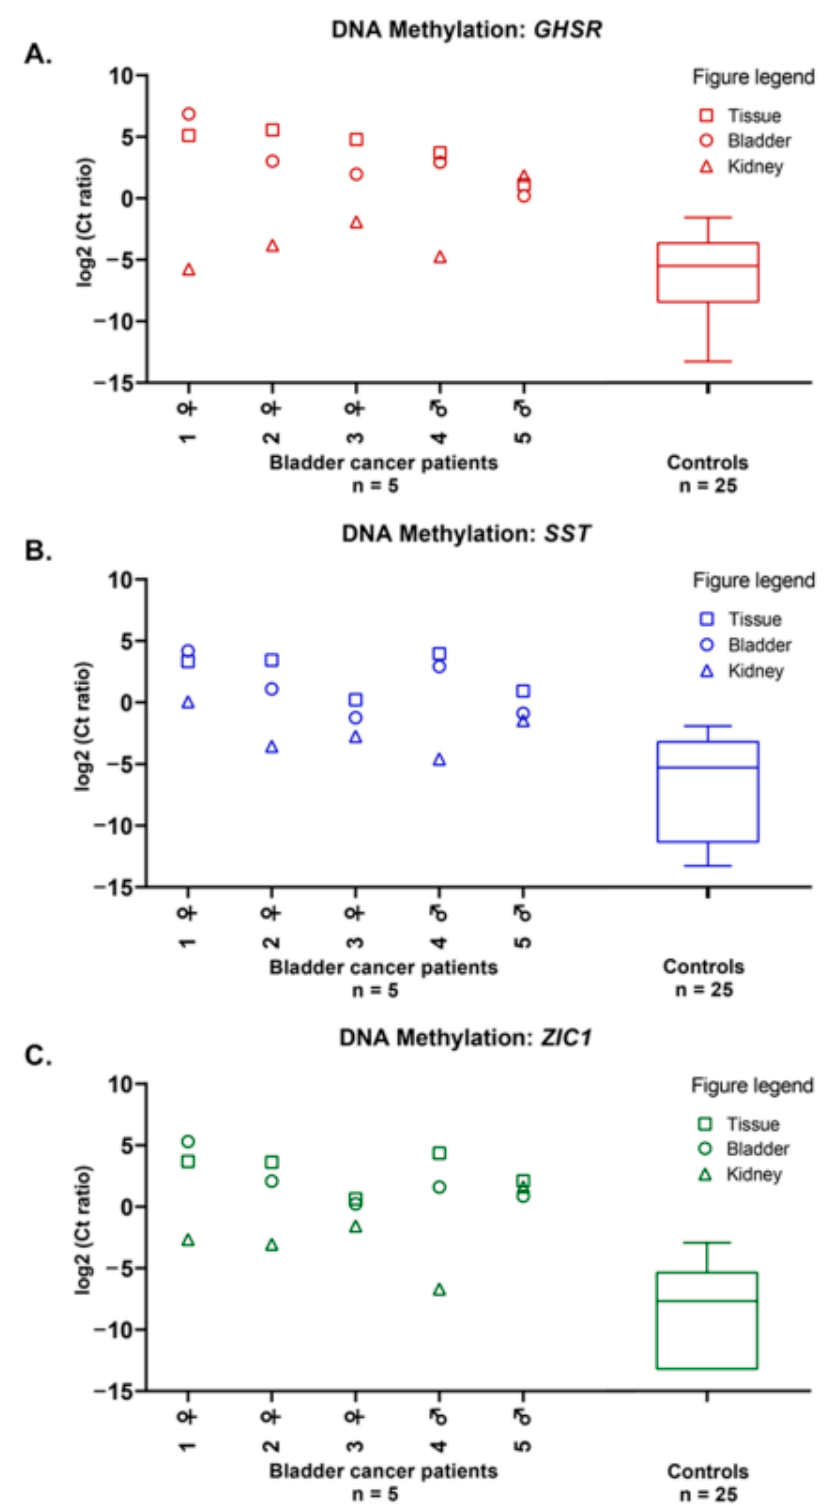
Figure 1. DNA methylation levels of markers GHSR ( A ), SST ( B ), and ZIC1 ( C ) in paired bladder tumor tissues (tissue, □ ), natural voided urine (bladder, о ), and nephrostomy urine (kidney, ∆ ) from five muscle-invasive bladder cancer patients, compared to natural voided urine from 25 gender- and age-matched controls. DNA methylation levels are represented by the log2-transformed Ct ratios. Boxplots show medians with the 25th and 75th percentile and whiskers range from the smallest to the largest value.